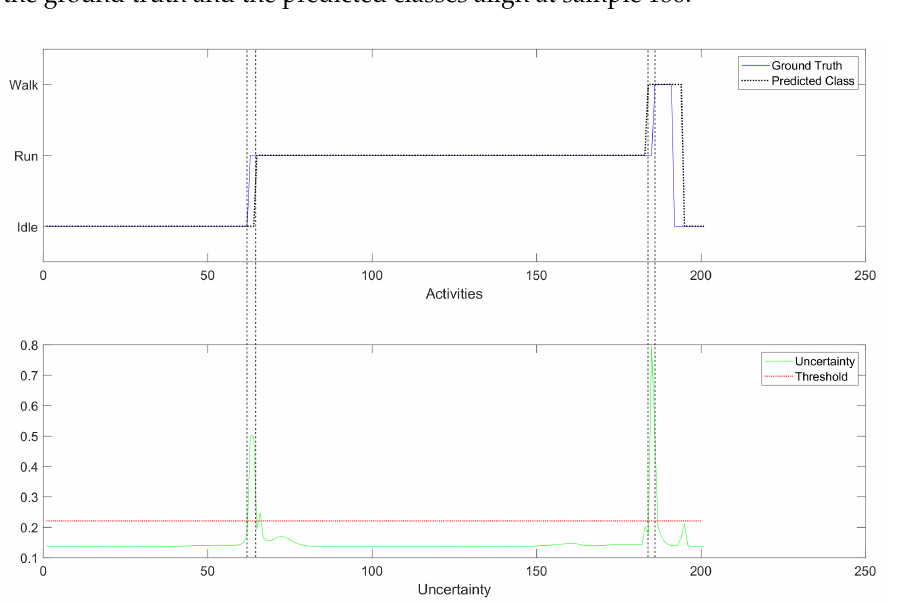
Figure 9. Accessing uncertainty in the activity